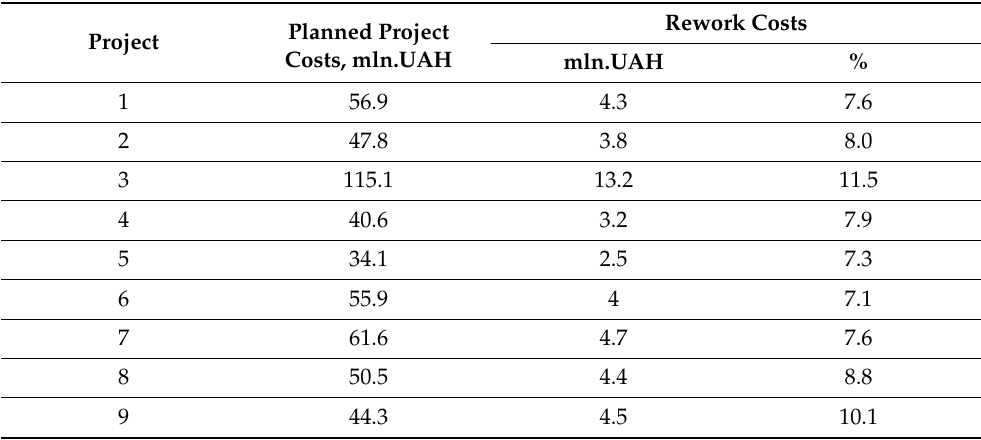
Table 1. The results of construction projects